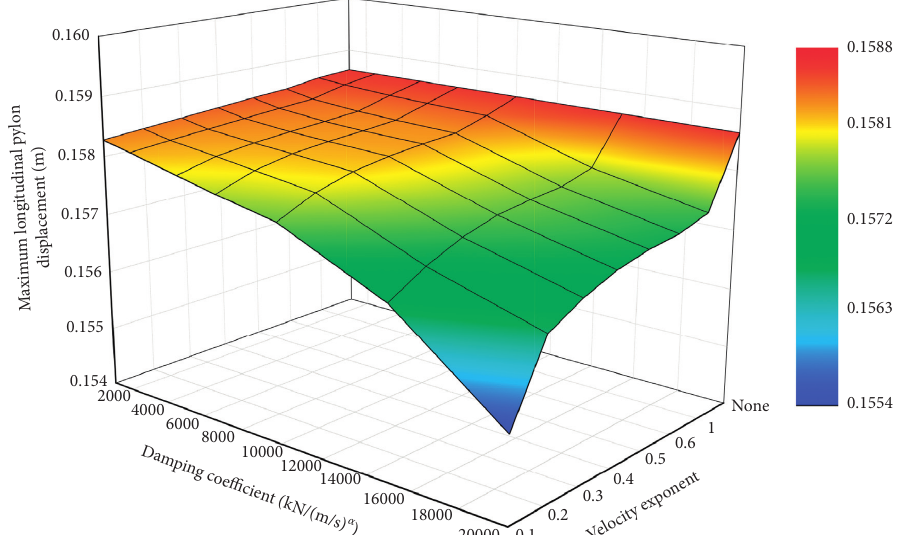
Figure 19: Maximum longitudinal pylon displacement W